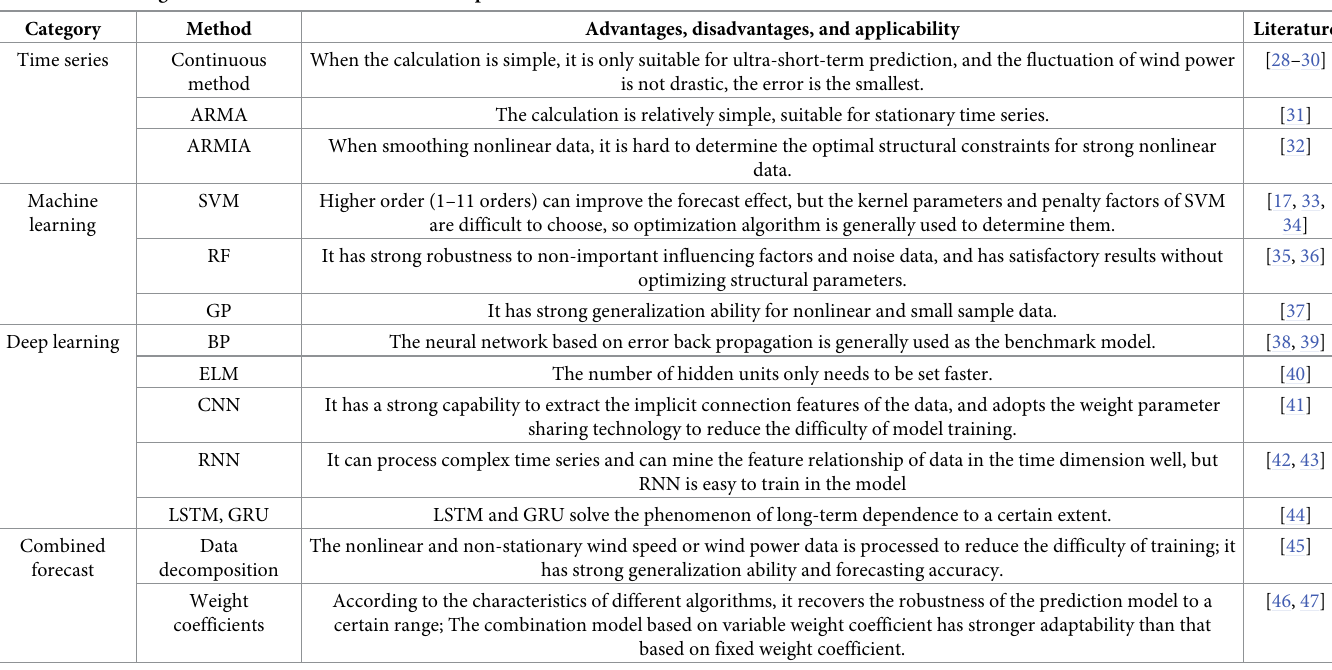
Table 1. Forecasting methods and characteristics of wind